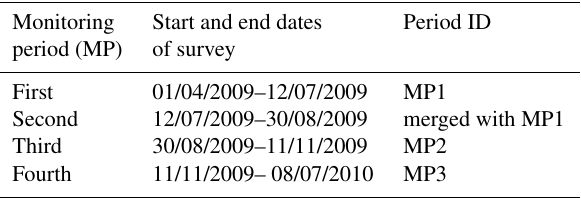
Table 1. Dates of TLS acquisitions. Note that for the analysis, the second survey was merged with the first one (see text for